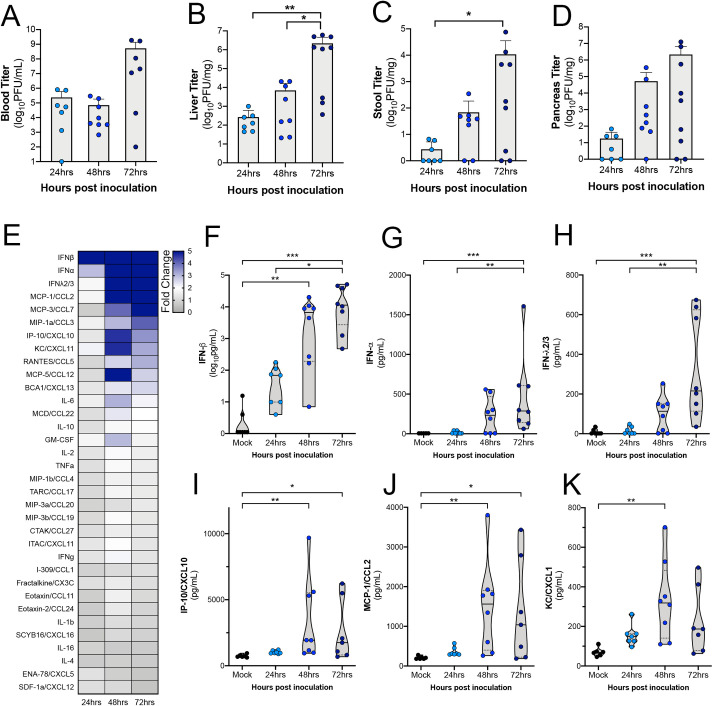
Cytokine levels increase with viremia in hFcRnTg32-IFNAR-/- animals.hFcRnTg32-IFNAR-/- animals IP inoculated with 104 PFU of E11 were sacrificed at 24 (light blue) 48 (blue), or 72 (navy) hours post inoculation. (A) Viral titers in the blood (log10PFU/mL) of adult animals (24hpi– 7, 48hpi– 8, 72hpi– 9 animals) are shown as mean ± standard deviation bars) and individual animals (points). (B-D) Viral titers in the liver (B), stool (C), and pancreas (D), (log10PFU/mg) from adult mice are shown as mean ± standard deviation bars and individual animals (points). (E) Heat map demonstrating the level of protein induction by Luminex-based assays shown as the fold change of from the average pg/mL of the uninfected animals to each individual animal concentration per protein then averaged within each timepoint. Proteins are sorted from largest fold change (blue) from uninfected to smallest fold change (gray) in 72hpi animals. (F-K) IFN-β (F), IFN-α (G), IFNλ2/3 (H), IP-10/CXCL10 (I), MCP-1/CCL2 (J), and KC/CXCL1 (K) protein levels expressed in the blood of each animal shown by timepoint. Data are shown with significance determined with a Kruskal-Wallis test with a Dunn’s test for multiple comparisons (*p<0.05, **p<0.005, ***p<0.0005, ****p<0.0001).